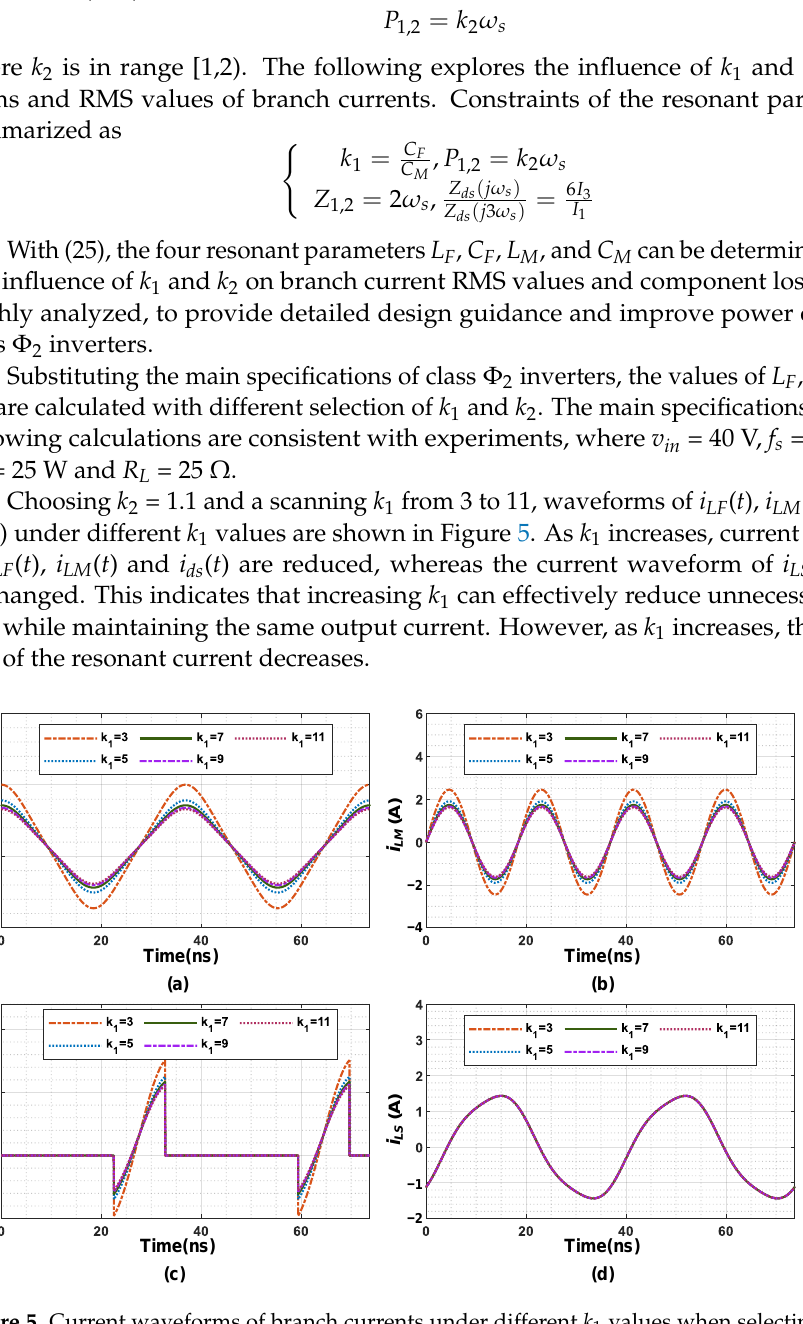
k 1 (d) Figure 6. RMS values of branch currents under different k 1 values when selecting k 2 = 1.1. ( a ) RMS values of i LF ( t ); ( b ) RMS values of i LM ( t ); ( c ) RMS values of i ds ( t ); ( d ) RMS values of i LS ( t ). Furthermore, at k 1 = 10 and a scanning k 2 from 1.05 to 1.25, waveforms of i LF ( t ), i LM ( t ), i ds ( t ) and i LS ( t ) under different k 2 values are shown in Figure 7. RMS values of branch cur- rents are shown in Figure 8. According to the calculation results, setting k 2 close to 1 can reduce the circling current in class Ф 2 inverters. However, to guarantee zero voltage-